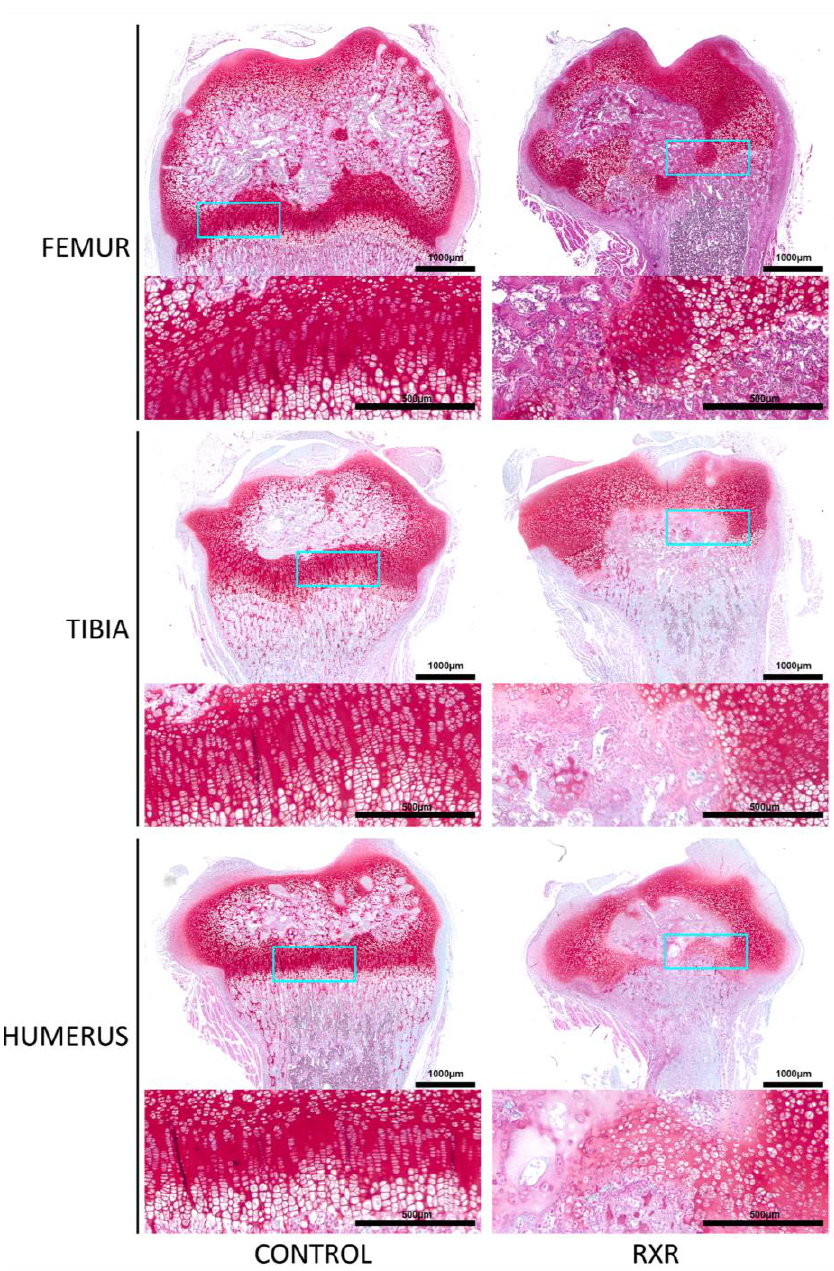
Figure 4. Disrupted growth plate morphology in P16 male rat long bones. Safranin O/fast green staining of bone sections highlights the appearance of disturbed growth plate organization and fusion of primary and secondary ossification centers in RXR agonist-treated males. Higher magnification in inset (scale bar = 1000 μm; inset = 500